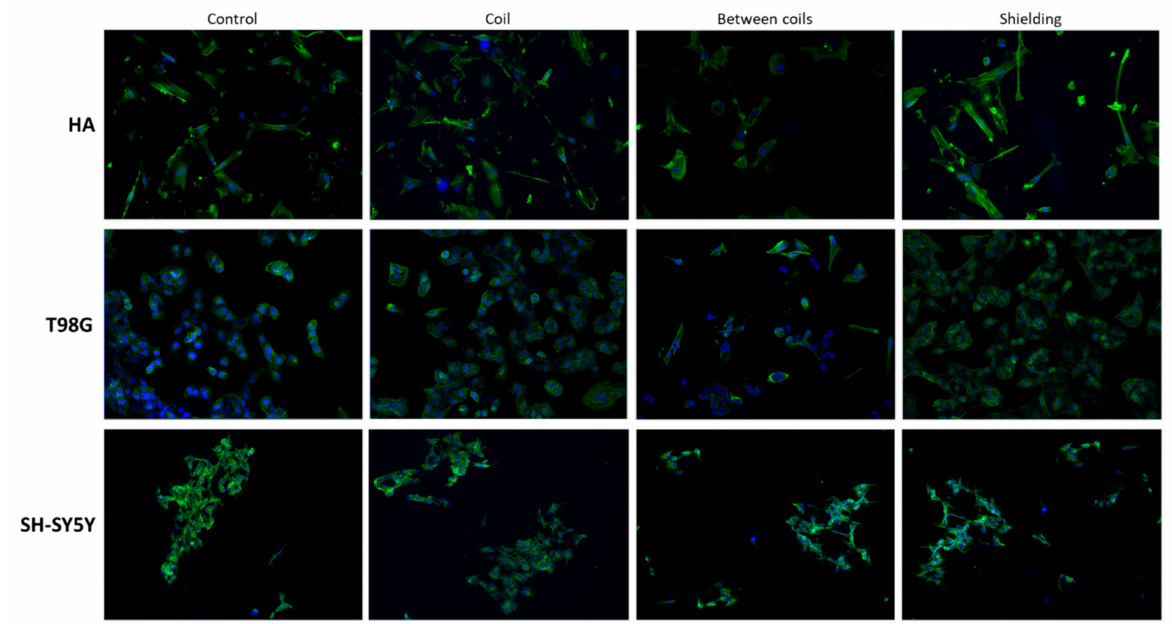
Figure 12. Fluorescent analysis of human neural cells (HA, T98G, SH-SY5Y) after exposure to EMF (87 kHz, 1.5 kW for 30 min) followed by 44 h regeneration. Cytoskeleton of cells was visualized by Phalloidin dye (green) and nuclei were stained by DAPI (blue). Representative photomicrographs were taken by WiScan ® Hermes System at magnification 100 ×